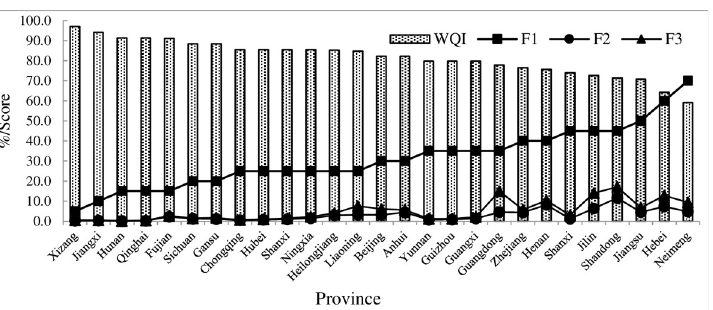
Fig 7. Comprehensive index scores of water quality at provincial boundaries (WQI- water quality index; F1-the percentage of the variables exceeding allowable limits; F2- the percentage of the quality of samples exceeding allowable limits during the study; F3- the amplitude exceeding the standard).